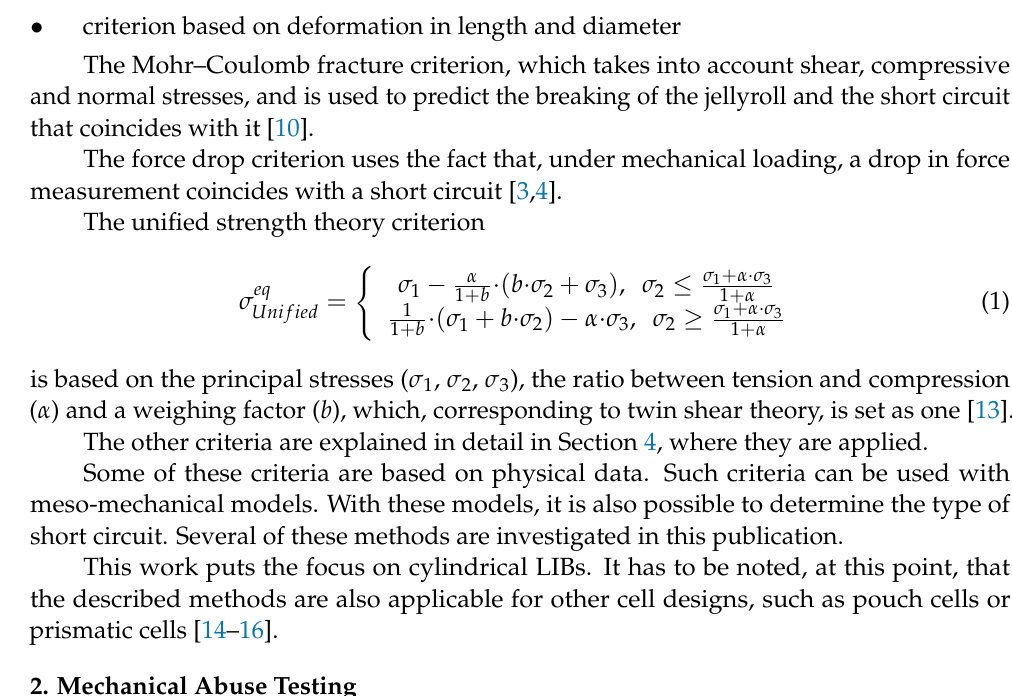
Figure 6. Radial crush impactor C1 (SOC comparison) force over displacement ( A ) and cell specimen after testing ( B ).